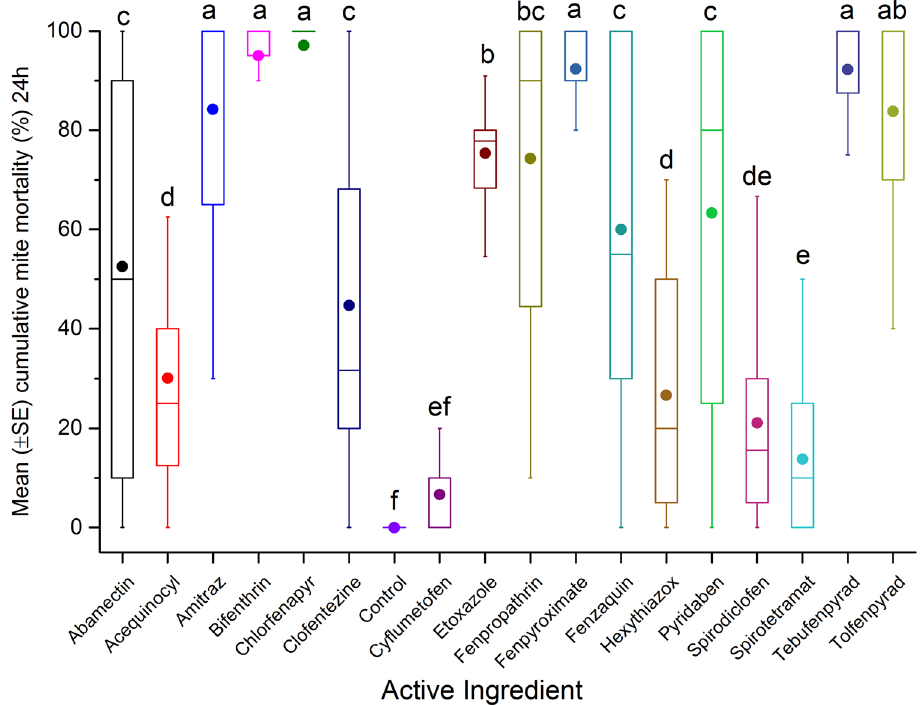
Figure 5. Mean (± SE) cumulative mite mortality (%) during 24 h exposure to different dilutions (0.0000117 µg/mite, 0.000117 µg/mite, 0.00117 µg/mite, 0.0117 µg/mite, 0.117 µg/mite or 1.17 µg/mite) of tested AIs in topical toxicity assay. Each Varroa mite was topically treated with 0.15 µL of each AI using micro- applicator. A group of mites was treated with different dilutions of amitraz as reference control, or left untreated (control) as negative control. The boxplots present the standard error (length of box), mean (solid circle), median (horizontal line), 5th and 95th percentiles (lower and upper vertical lines). Each box indicates average mortality for replications of each AI (n = 24) or control (n = 4). Means with the same letter among treatments are not significantly different ( p >